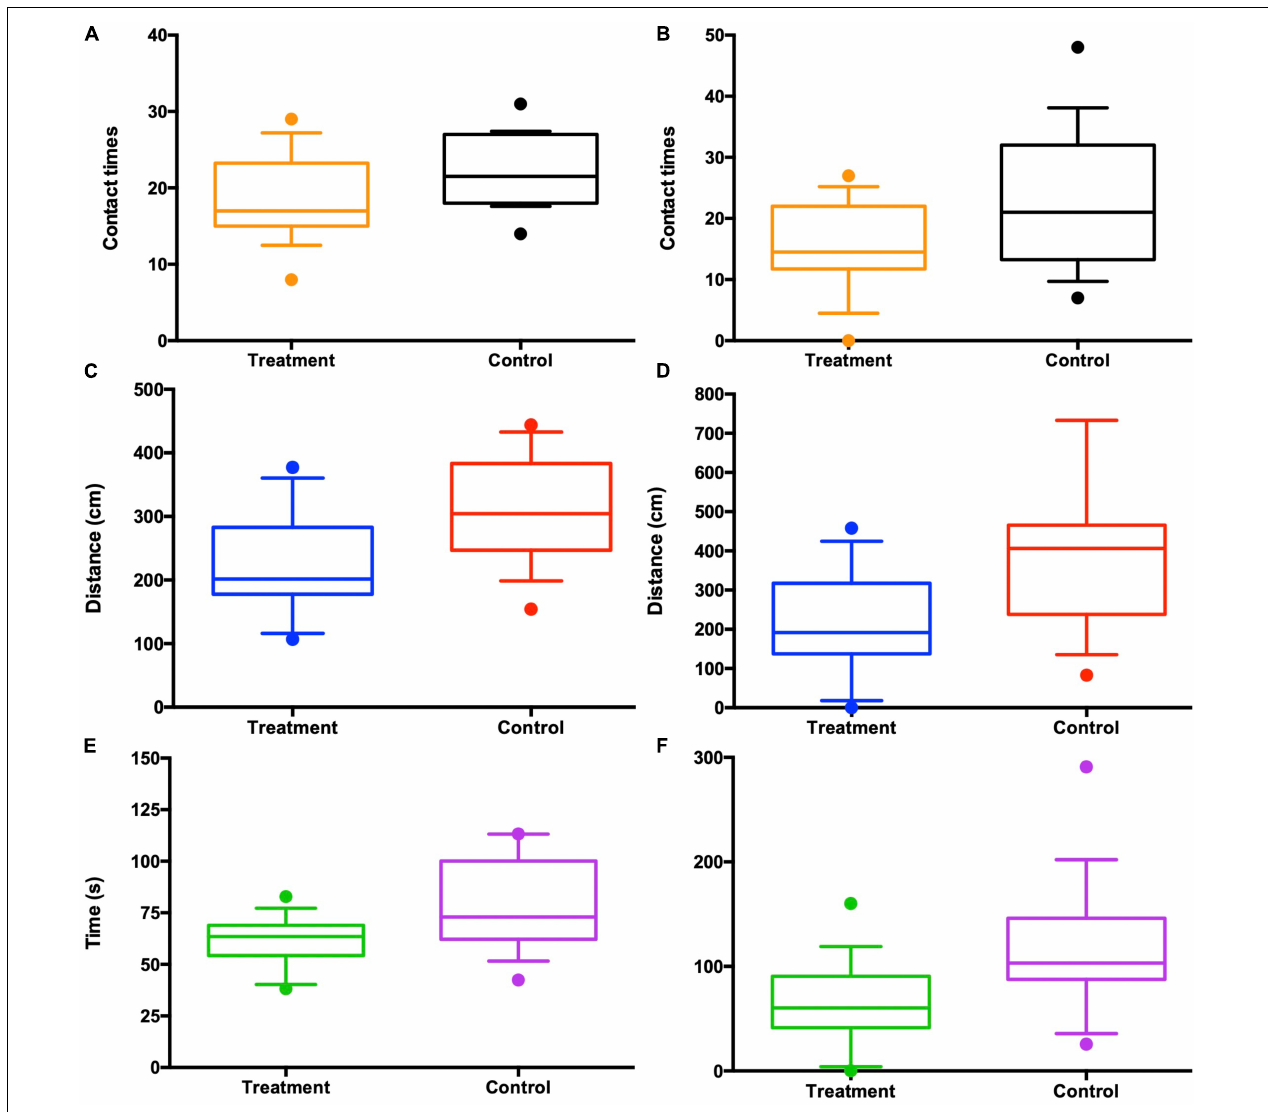
FIGURE 6 | Antibiotic-treated females lost the attractiveness to both control ( n = 10) and antibiotic-treated males ( n = 10) in the three-chambered sociability test, as seen from the contact times with the females (A,B) , the travel distances in each chamber (C,D) , and the time spent in each chamber (E,F) . “Control” in the x -axis appears to be control females and “Treatment” antibiotic-treated females chosen by